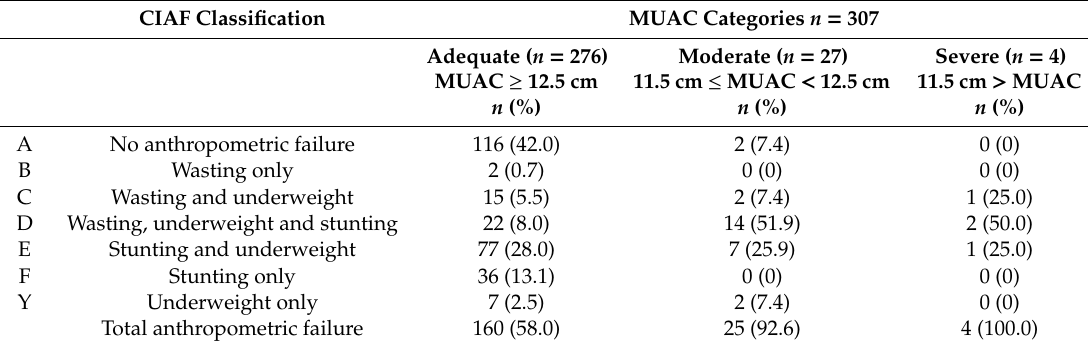
Table 5. Distribution of Santal children in mid-upper arm circumference (MUAC) categories across the